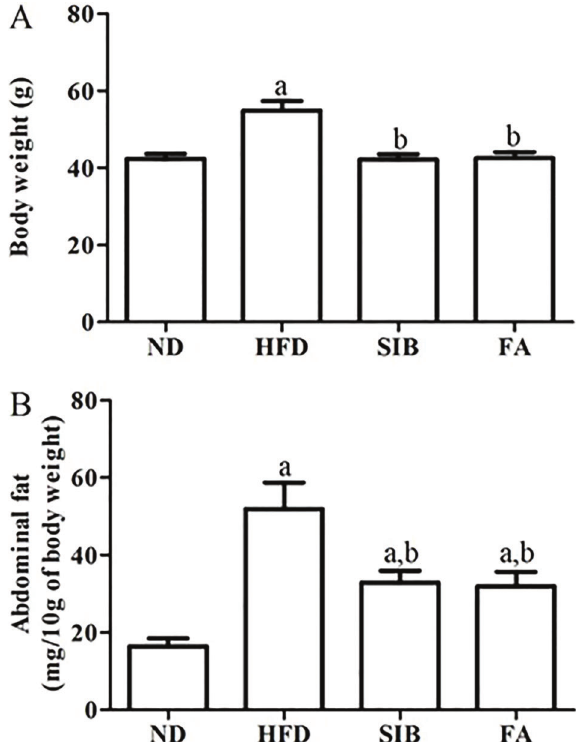
Figure 2. Effect of ferulic acid (FA) and sibutramine (SIB) on body weight ( A ) and abdominal fat content ( B ) in mice fed a HFD during 15 weeks. Results are reported as means ± SE. ND: normal diet; HFD: high-fat diet. a , P o 0.05 vs ND; b , P o 0.05 vs HFD (one- way ANOVA followed by Student-Newman-Keuls